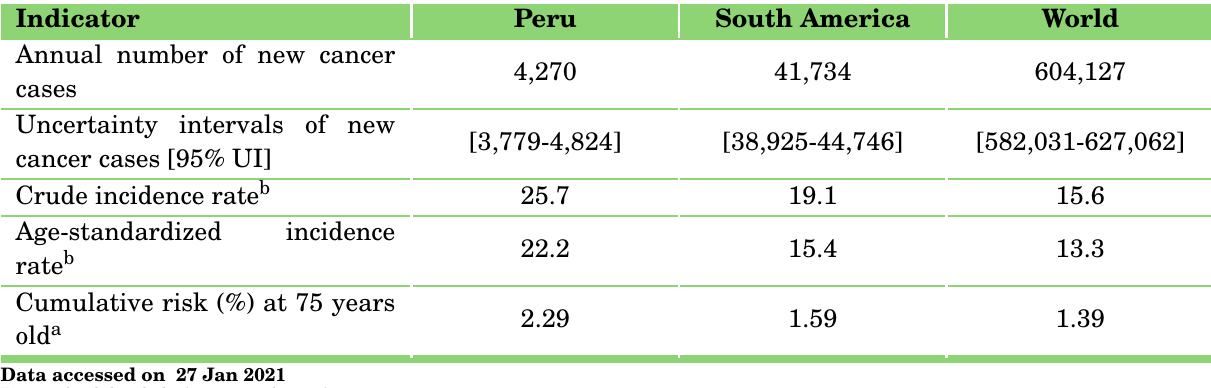
Table 2: Cervical cancer incidence in Peru (estimates for